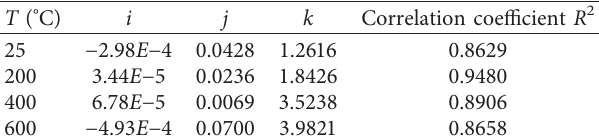
Figure 12: Relationship between dynamic elasticity modulus and incident energy. Table 2: Parameter values of dynamic elasticity modulus and incident energy.